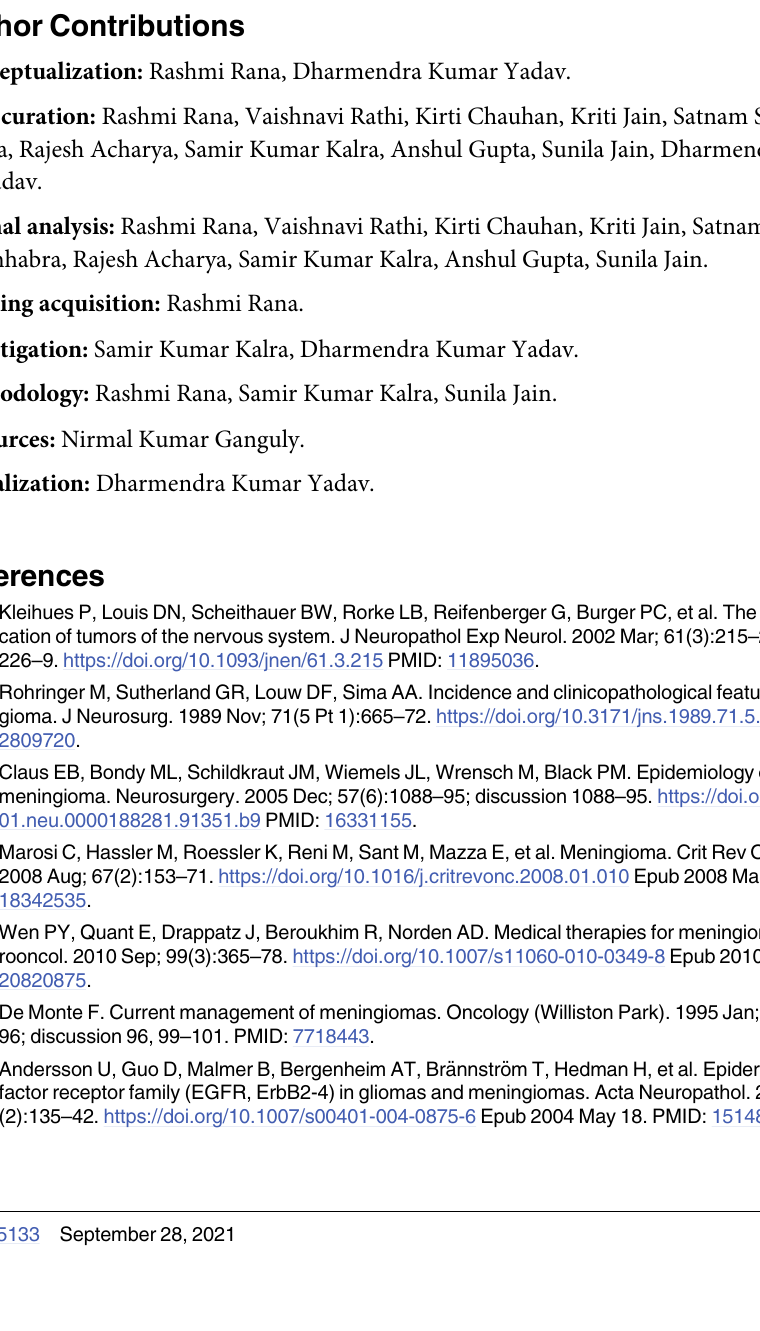
results seen. S3 Fig. Western blotting result by Anti-EGFR vIII antibody not detected any